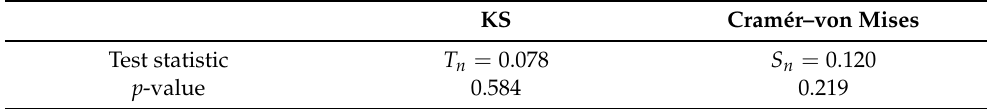
Table 5. Goodness-of-fit test for C θ